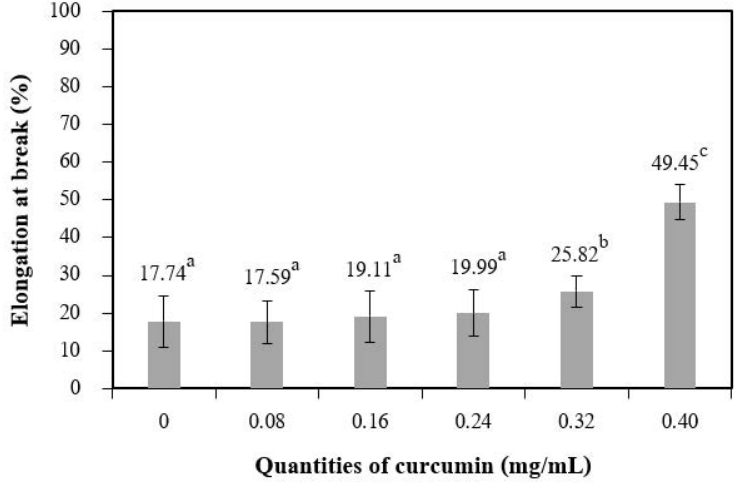
Figure 9. Elongation at break of chitosan film incorporated with various curcumin quantities. Results different letters are statistically different ( p <